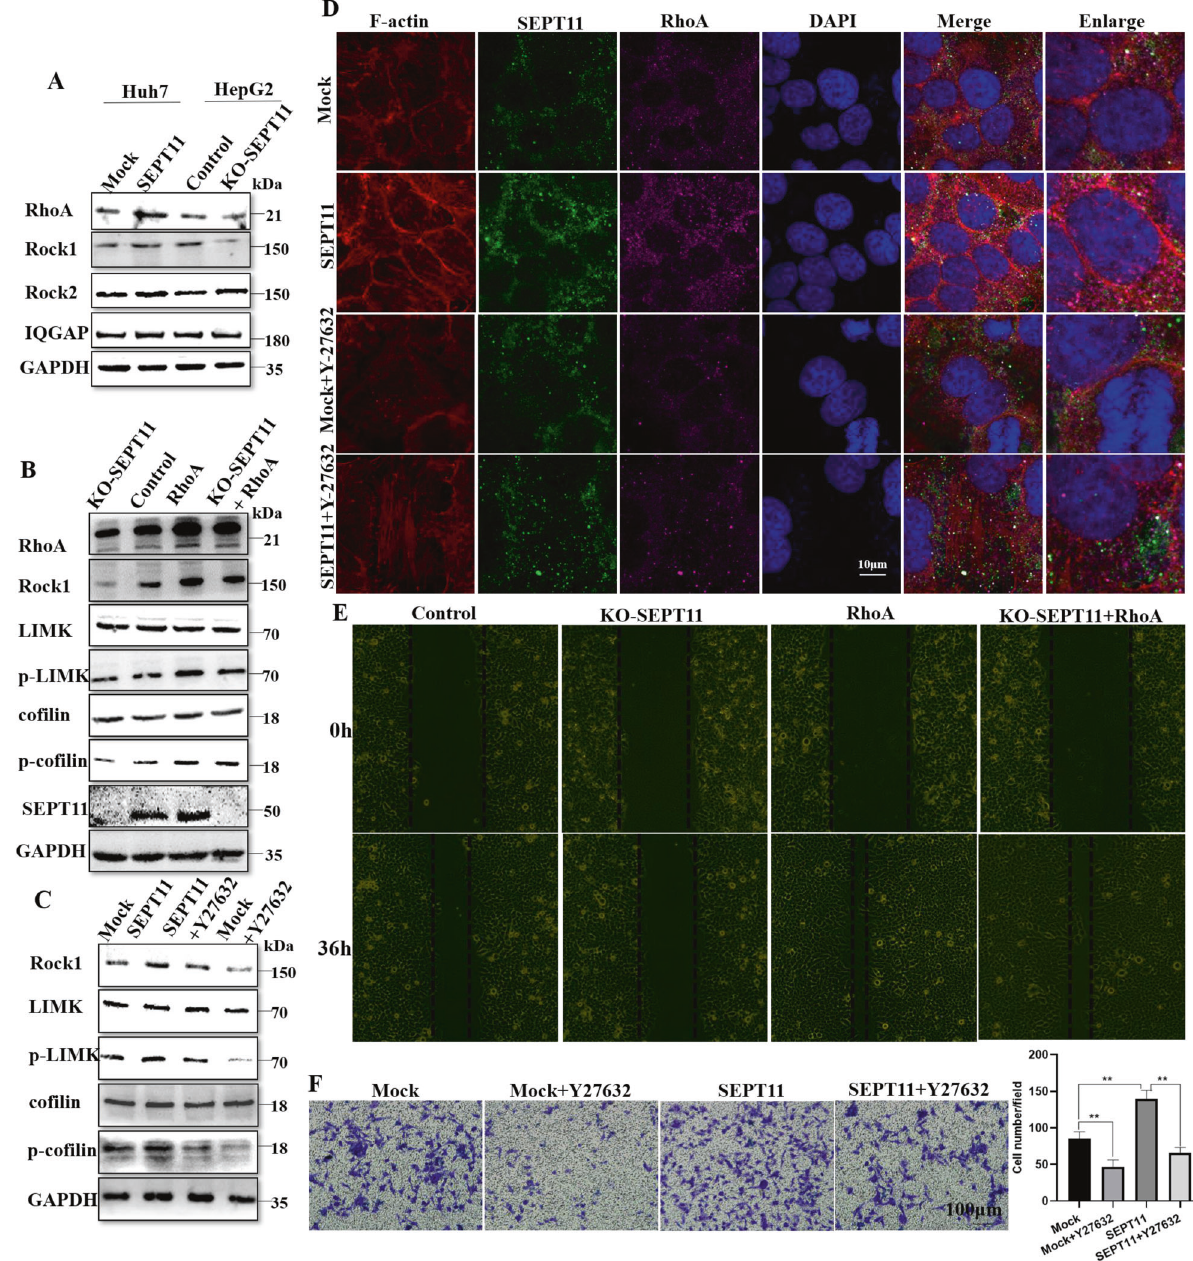
Fig. 5 SEPT11 activates LIMK/co fi lin pathway to promote HCC migration. A WB was used to detected the effect of SEPT11 expression on several key factors downstream of RhoA; B The effect of RhoA on SEPT11-activated LIMK/co fi lin pathway was measured by WB; C The effect of ROCK1 inhibitor Y27632 on SEPT11-activated LIMK/co fi lin pathway was detected by WB; D The effect of Y27632 on SEPT11-regulated actin arrangement and increase was tested by cellular immuno fl uorescence; E Scratch assay was used to detect the effect of RhoA on cell migration by inhibited by KO-SEPT11; F Transwell assay was used to detect the effect of Y27632 on cell migration regulated by cells, and its deletion abolishes the ability of ERK3 to promote lung cancer cell migration and invasion [47]. CDK2 interacts with SEPT2 to stabilize SEPT2 in HCC cells, and HCC with high expression of both CDK2 and SEPT2 is more prone to recurrence and may be more aggressive [48]. As a new member of the septin family, we reported the function of SEPT11 in HCC progression for the fi rst time. In this study, we demonstrated the function of SEPT11 in promoting the metastasis of HCC, and preliminarily explored the related molecular mechanism of its promoting HCC metastasis.